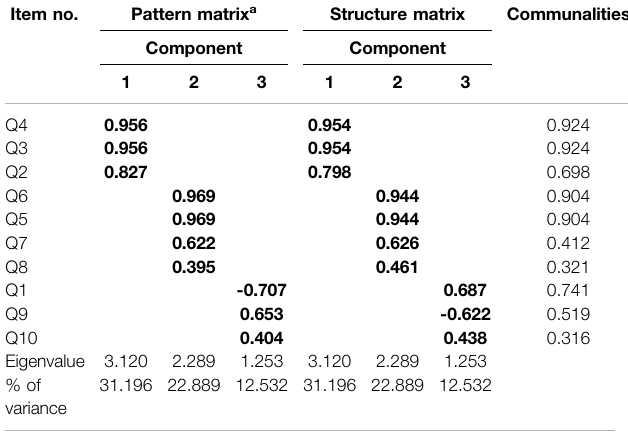
Extraction method: principal component analysis (PCA). Rotation Method: Oblimin with Kaiser normalization. a Rotation converged in nine iterations.